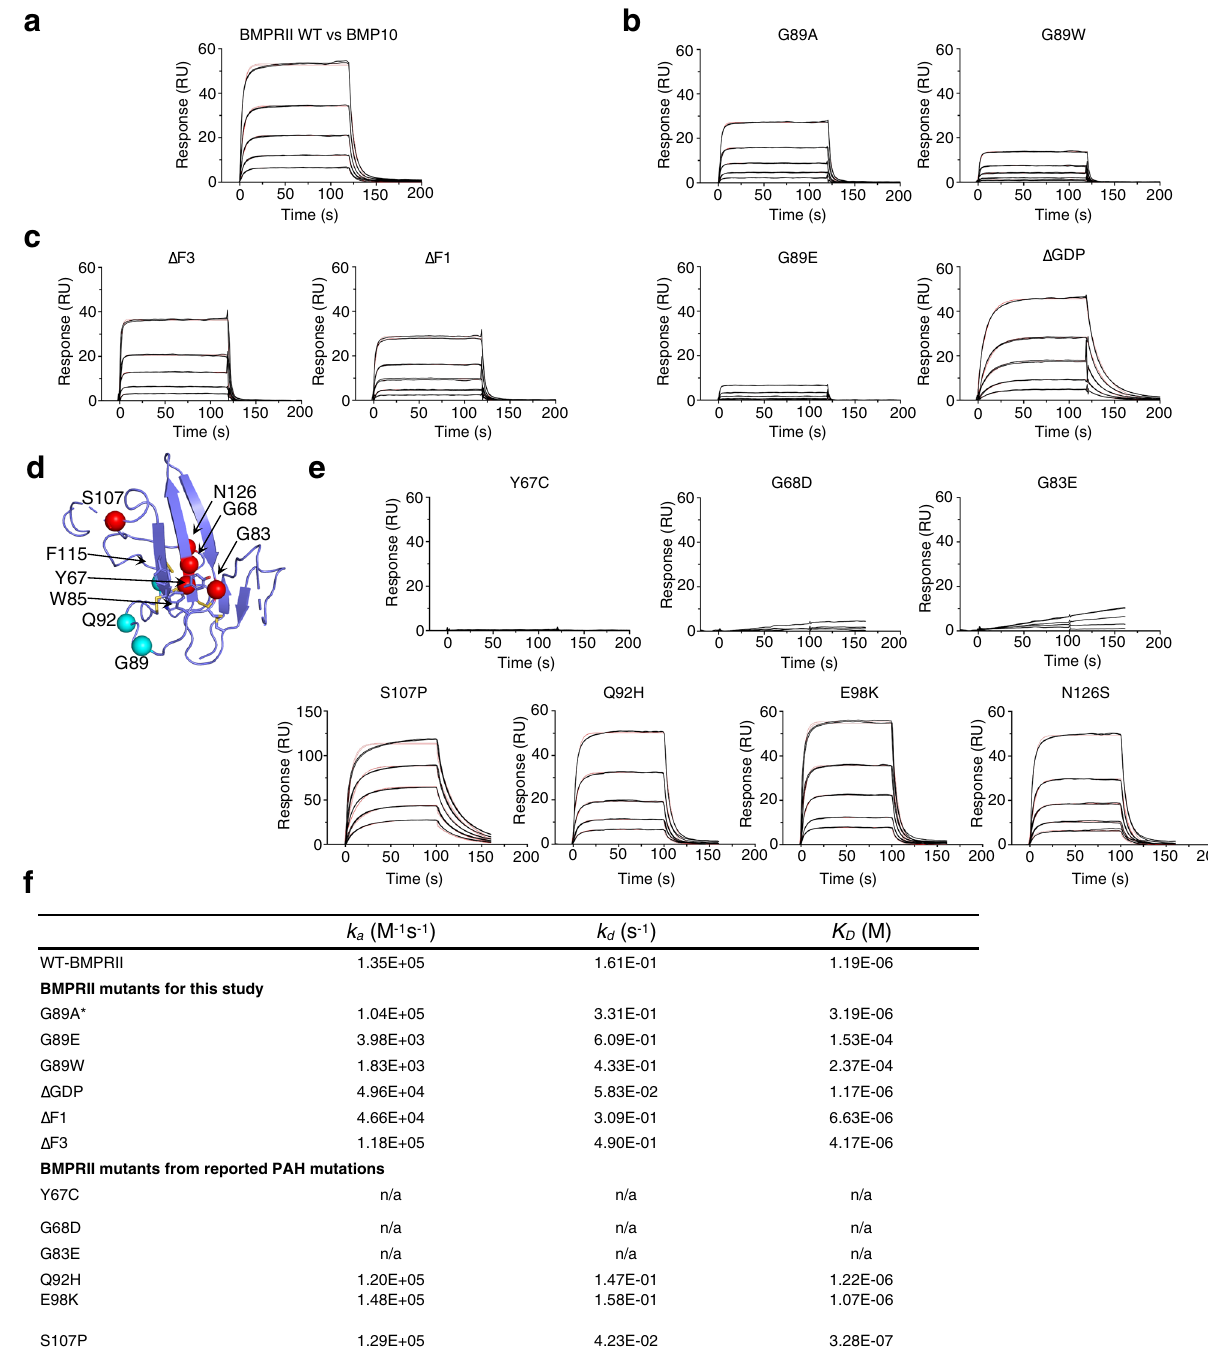
Fig. 7 BMP10 binding to BMPRII and its mutant proteins. a The sensorgram of monomeric BMPRII WT ECD binding to BMP10 immobilised on a CM5 Biacore chip. Control experiments of ALK1-Fc and BMPRII-Fc binding to the same BMP10 chip are shown in Supplementary Fig 10. b G89-containing A-loop is essential for BMPRII binding to BMP10. c F1-loop and F3-loop deletion mutants binding to BMP10. d Locations of PAH mutations 6 on the BMPRII ECD structure (purple cartoon). Red spheres: residues predicted to be deleterious; cyan spheres, residues predicted to be benign. e Sensorgrams of BMPRII ECD proteins containing PAH mutations binding to BMP10. f . Summary of kinetic parameters from the Biacore binding experiments. *G89A has also been found in an hereditary PAH case, but predicted to be a benign mutation. WT wild type, ECD extracellular domain, Δ F1(F3) deletion of fi nger 1 ( fi nger 3) residues, Δ GDP deletion of Gly, Asp and Pro in the A-loop. M Molar concentration, s = second, k a = association rate constant, k d = dissociation rate constant, K = k /k D d a .